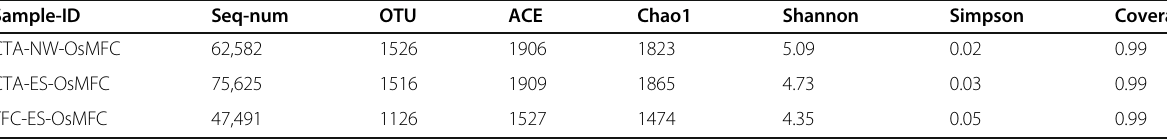
Table 2 Species diversity of microbial communities on different membranes